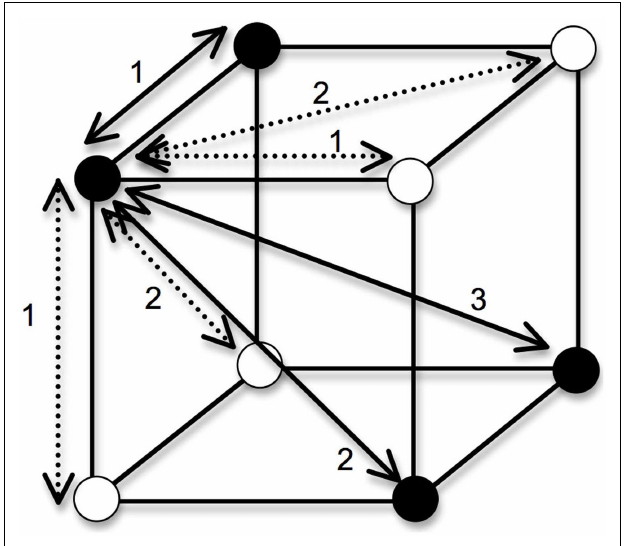
FIGURE 2 | Distances between objects in aType II. In generating the predictions of a simple exemplar model, we posit an XOR categorization in which the filled circles belong to one category, and the empty circles belong to a different category. Categorization accuracy is a function of the sum of the city-block distances of an object to the objects in its own category, divided by the sum of its distances to all objects. For the object in the front-upper-left of the cube, the within-category distances are shown by solid lines and the between-category distances shown by dashed lines. Not included in the figure is the distance of 0 that the object has to